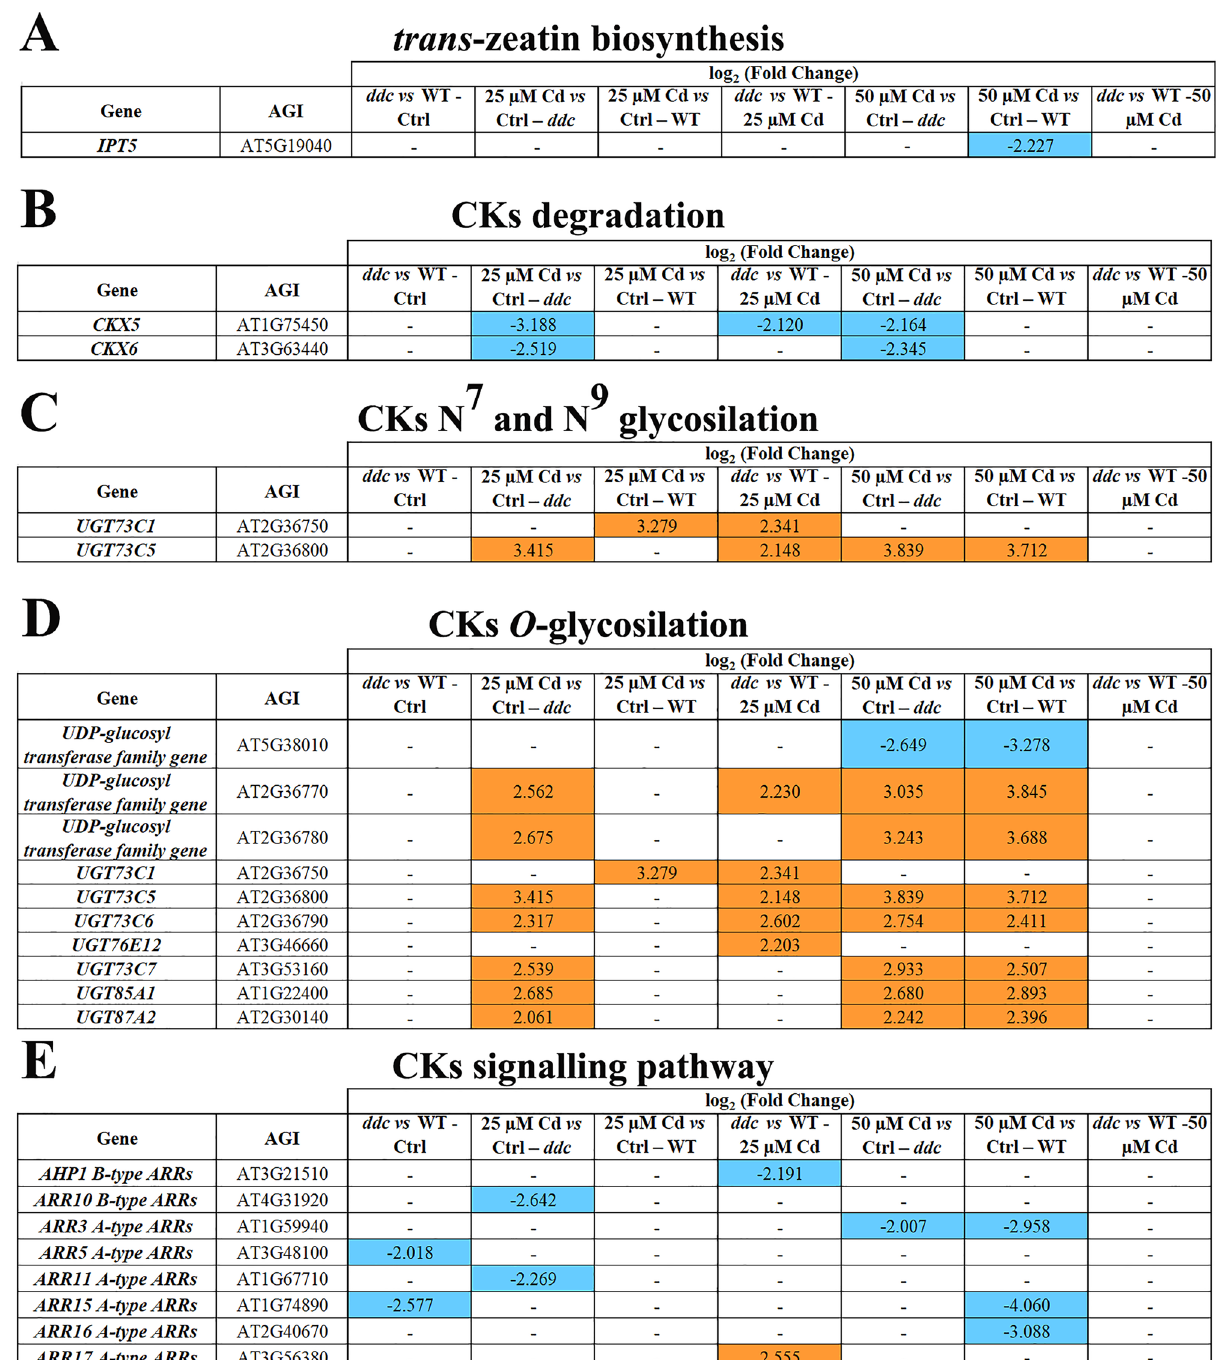
Figure 3. Genes differentially expressed (DEGs) along the pathway of ( A ) trans- zeatin biosynthesis, ( B ) CKs degradation, (C) CKs N 7 - and N 9 - glucoside biosynthesis, ( D ) CKs O- glycosylation and ( E ) CKs signalling in ddc and WT plants identified through a transcriptomic approach. For each comparison, the log 2 (fold change) of the analysed DEGs was shown in orange and in blue for the upregulated and downregulated genes, respectively. Plants were grown for 21 DAG in long day condition: (i) on growth medium added with 25 or 50 µM Cd; (ii) on growth medium without Cd as control